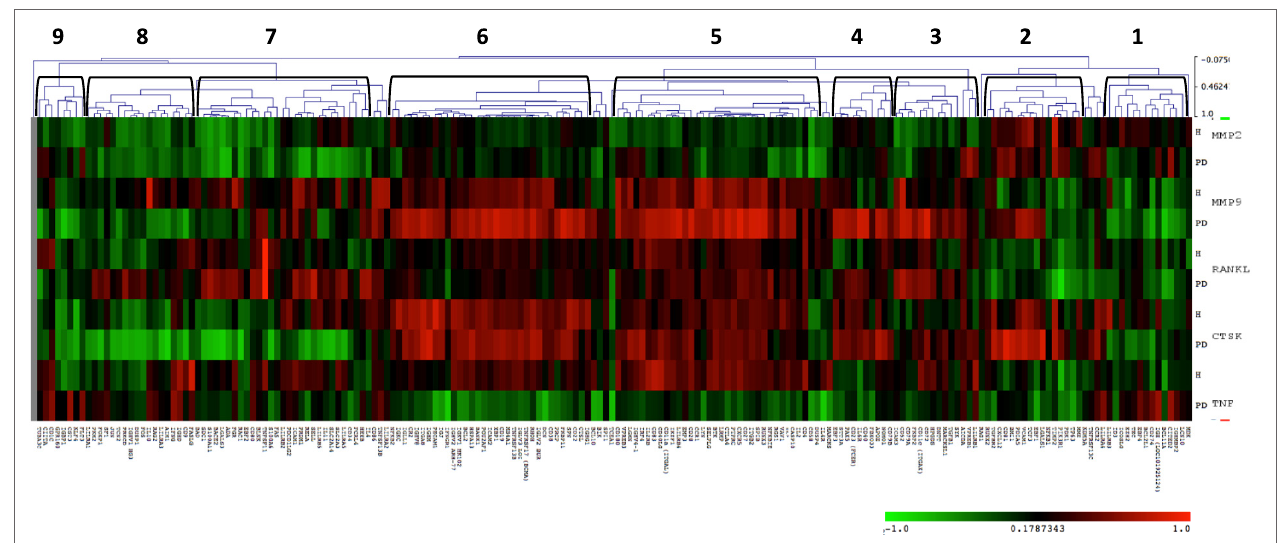
FigUre 5 | heatmap depicting the distribution of correlations of B cell/plasmacyte genes with tissue destructive genes (MMP2, MMP9, cTsK, TnF, and ranKl) in healthy gingival tissues (h, n = 23) and periodontitis tissues (PD, n = 11) of adult and aged animals . The graph displays differences in gene expression in the adult and aged tissues compared with control levels displayed in a group of 10 healthy animals from 3 to 7 years of age. Green denotes negative correlation and red denotes positive correlation with the expression of the tissue destructive genes. The brackets signify the nine gene clusters created based on similarity indices of